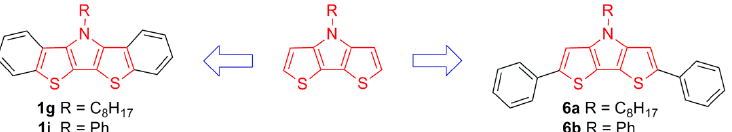
Figure 5. Analogous DTP-based species utilized to compare the relative effects of benzannulation verses simple phenyl substitution. Table 2. UV ‐ visible data for various bis[1]benzothieno[3,2 ‐ b :2 ′ ,3 ′‐ d ]pyrroles and dithieno[3,2 ‐ b :2 ′ ,3 ′‐ Table 2. UV-visible data for various bis[1]benzothieno[3,2- b :2 (cid:48) ,3 (cid:48) - d ]pyrroles and dithieno[3,2- b :2 (cid:48) ,3 (cid:48) - d ] pyrrole.